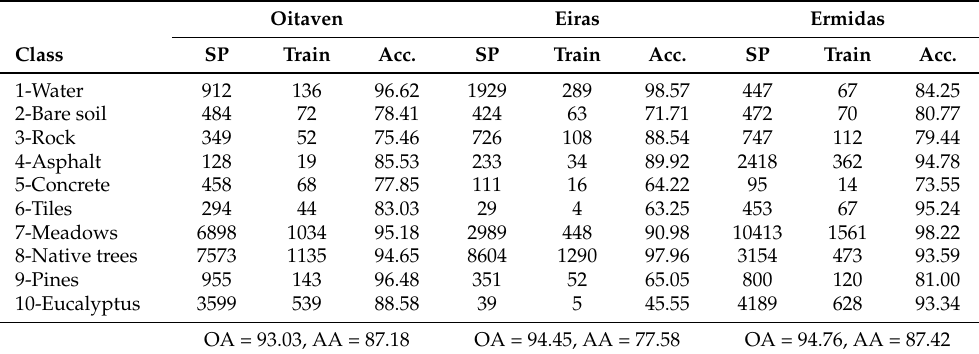
Table 4. Disaggregated data for the Oitaven, Eiras and Ermidas datasets using the WP+FV+3KELM chain and 15% of training superpixels. For each class, the number of superpixels with reference data, the superpixels used for training, and the accuracies obtained are